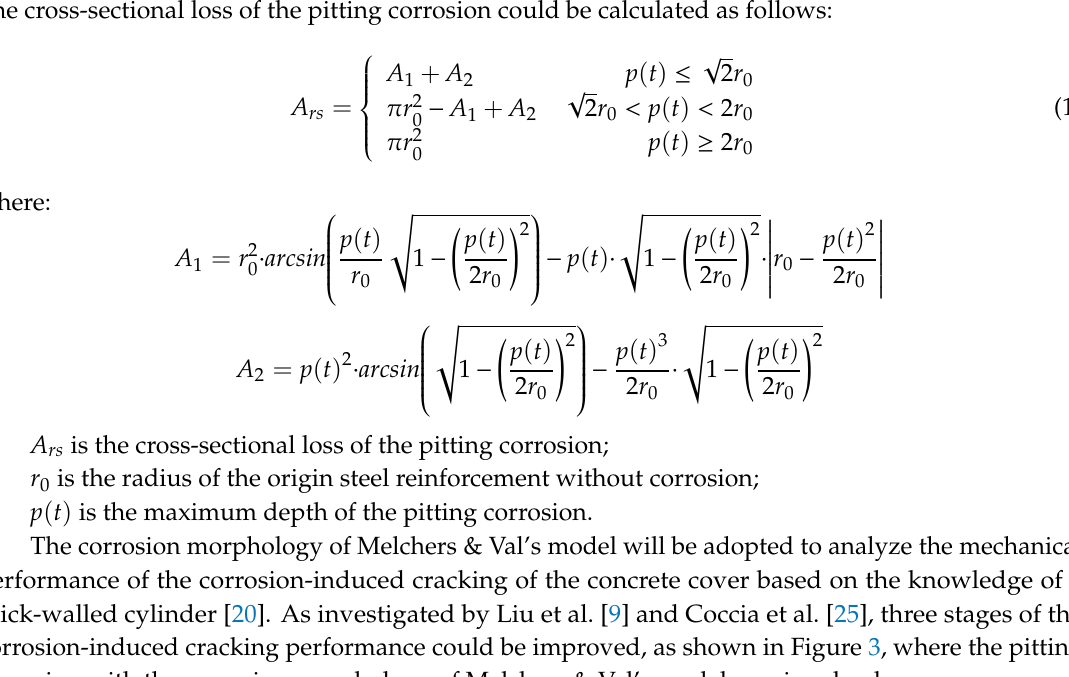
Figure 2. Simplification and comparison of the corrosion morphology [22–23]. ( a ) Non-corroded image. ( b ) Natural corroded image. ( c ) Melchers & Val’s model.